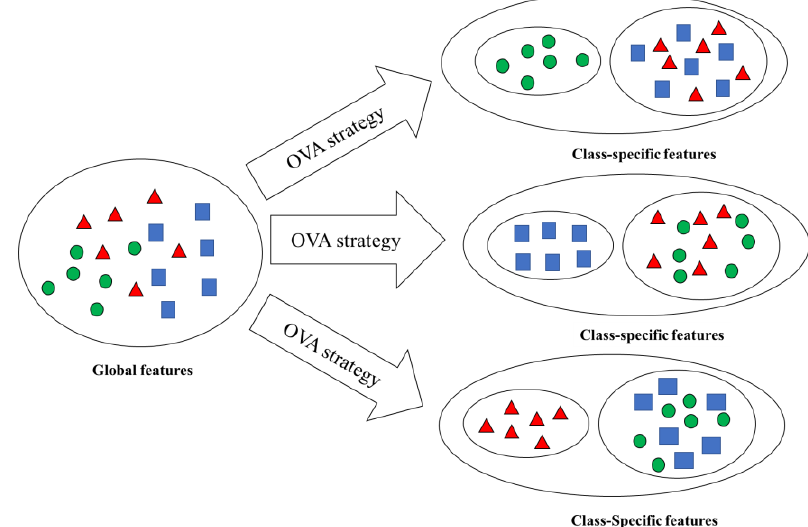
Figure 1. The idea of solving the multi-class classification problem using class-specific features by one-against-all (OVA) strategy.